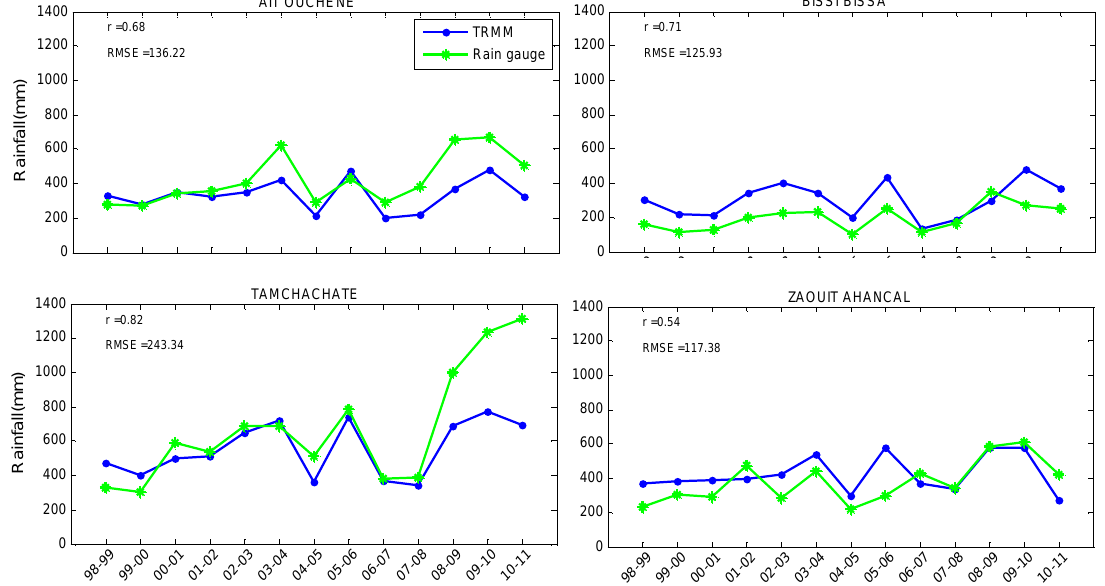
Figure 10. Annual rainfall obtained from representative TRMM pixels and rain gauges data for the period 1998–2010.